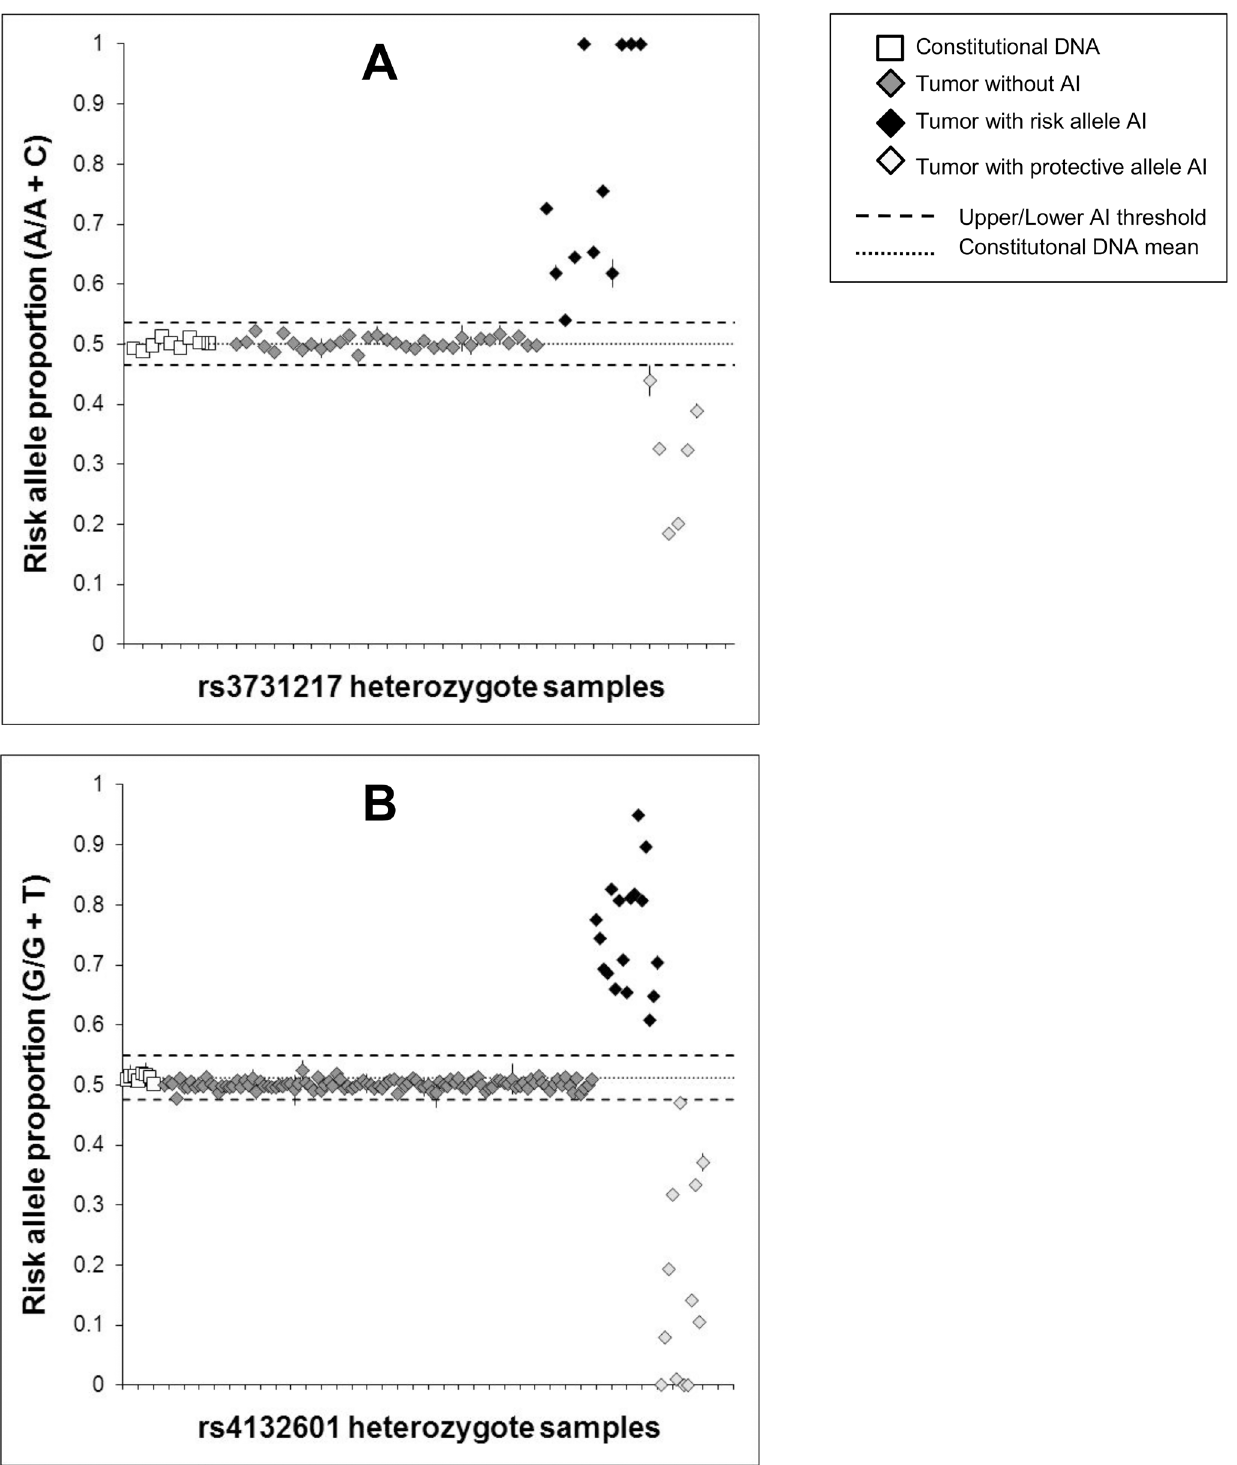
Fig 1. Risk allele proportions at genomic loci with somatic loss. Allelic copy number was measured in constitutional DNA and leukemia bone marrow (tumor) DNA from ALL patients heterozygous for CDKN2A tagging SNP rs3731217 (A), and IKZF1 SNP rs4132601 (B). Risk allele proportions are displayed as a fraction of the total allelic copy number measured in each patient using ddPCR. Each subject was assayed in duplicate, and error bars represent the standard error of the mean (some error bars not visible due to their range falling within boundaries of the data point). Upper/lower thresholds of allelic imbalance (AI) were +/- 3 SDs from the mean allelic proportion from repeat measurements in constitutional DNA samples (white squares). For rs3731217, 11